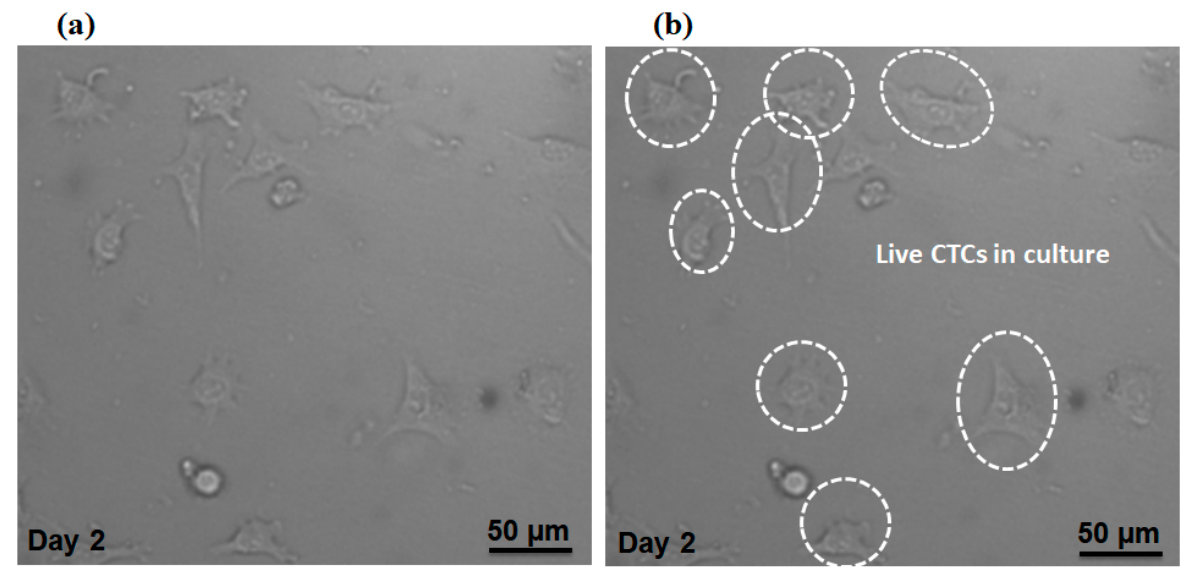
Figure 9. ( a ) Microscopic image for separated CTCs which were cultivated for 48 h. ( b ) Selected cells are live CTCs.